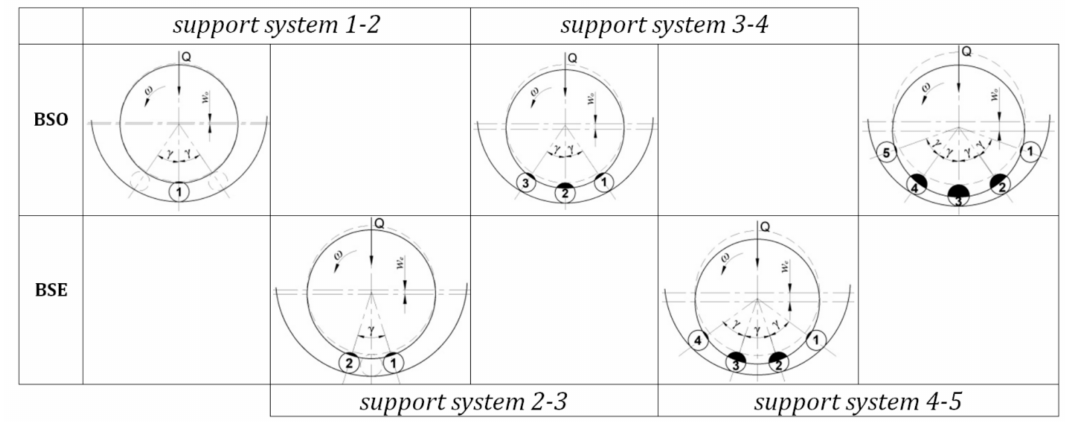
Figure 3. Support systems of rolling